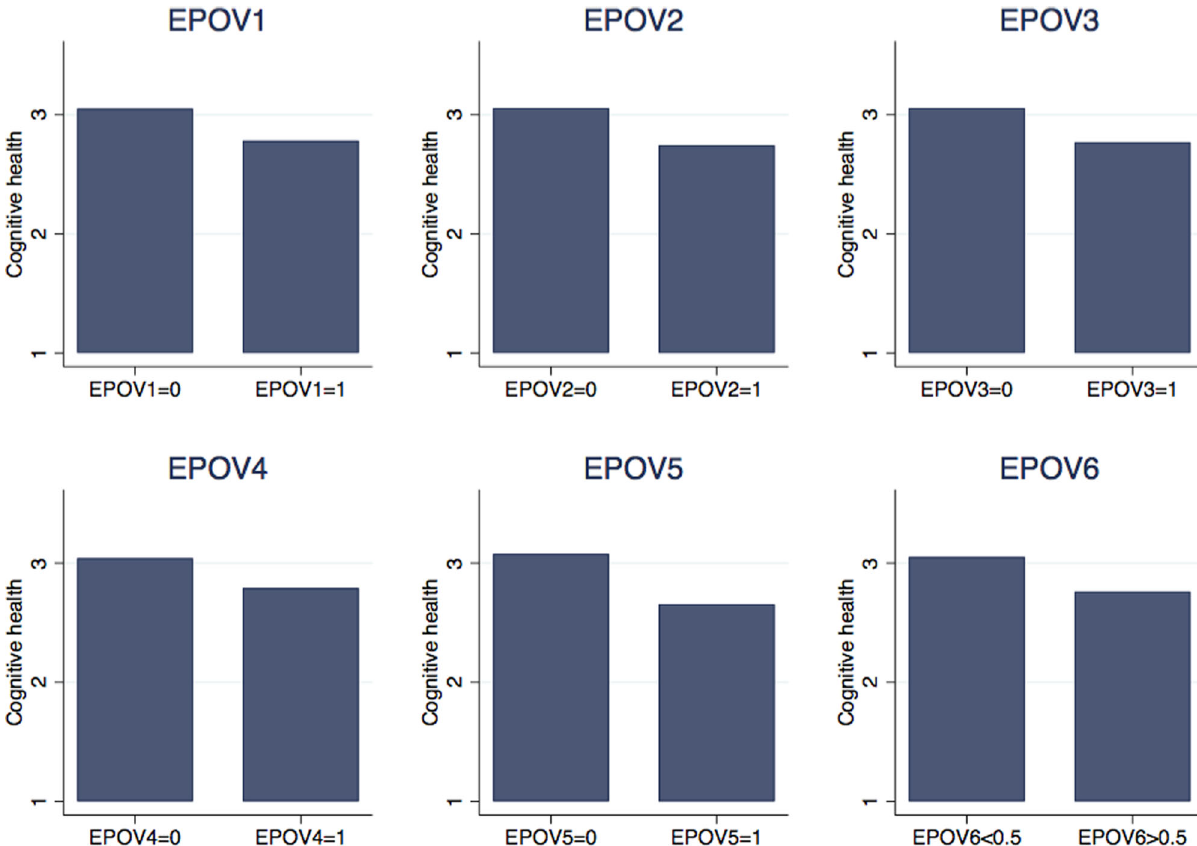
Fig. 3 Different measures of EPOV and CH. EPOV1-EPOV6 represent six different EPOV measures. Higher scores represent better CH